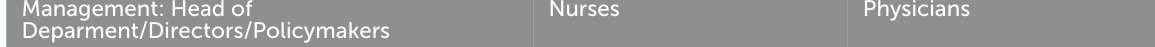
TABLE 2 Priority themes among different types of health professionals regarding the role of hospitals in recovery from COVID-19. Management: Head of Deparment/Directors/Policymakers